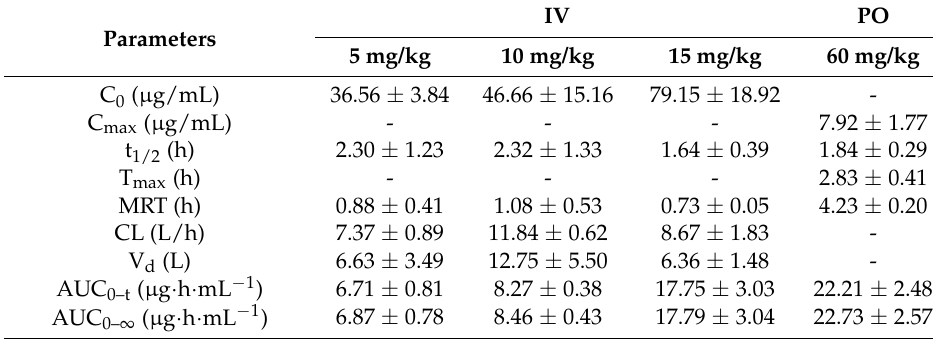
Table 5. Mean pharmacokinetic parameters after intravenous and oral administration of sodium danshensu in 24 beagle